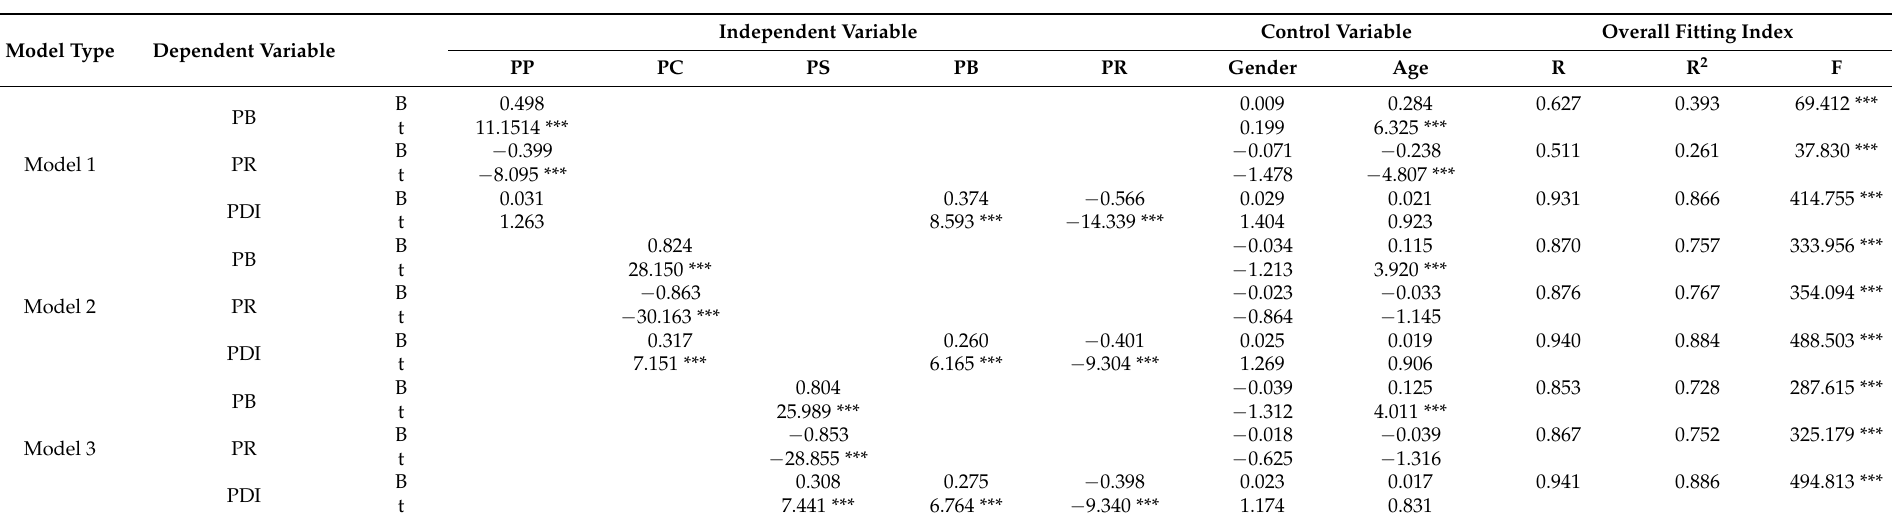
Table 6. Mediating effect test